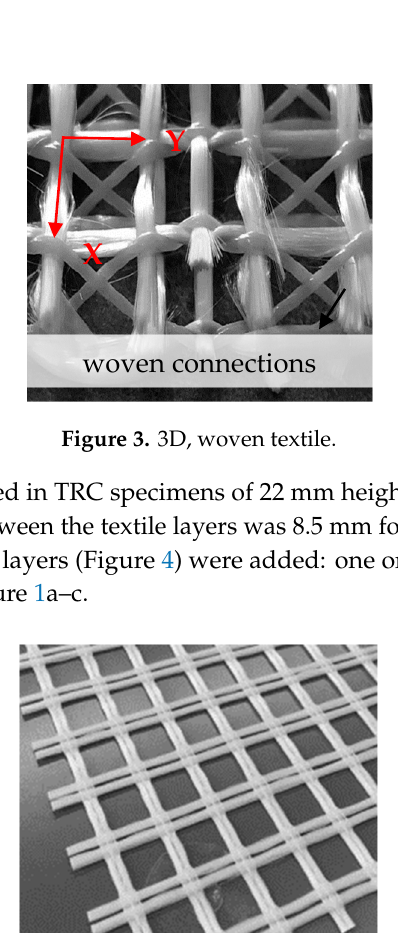
Figure 2. 3D, knitted textile.